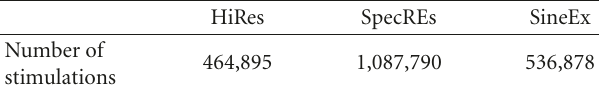
Table 2: Number of stimulations for 50 sentences of the HSM sentence test [28] with HiRes, SpecRes, and